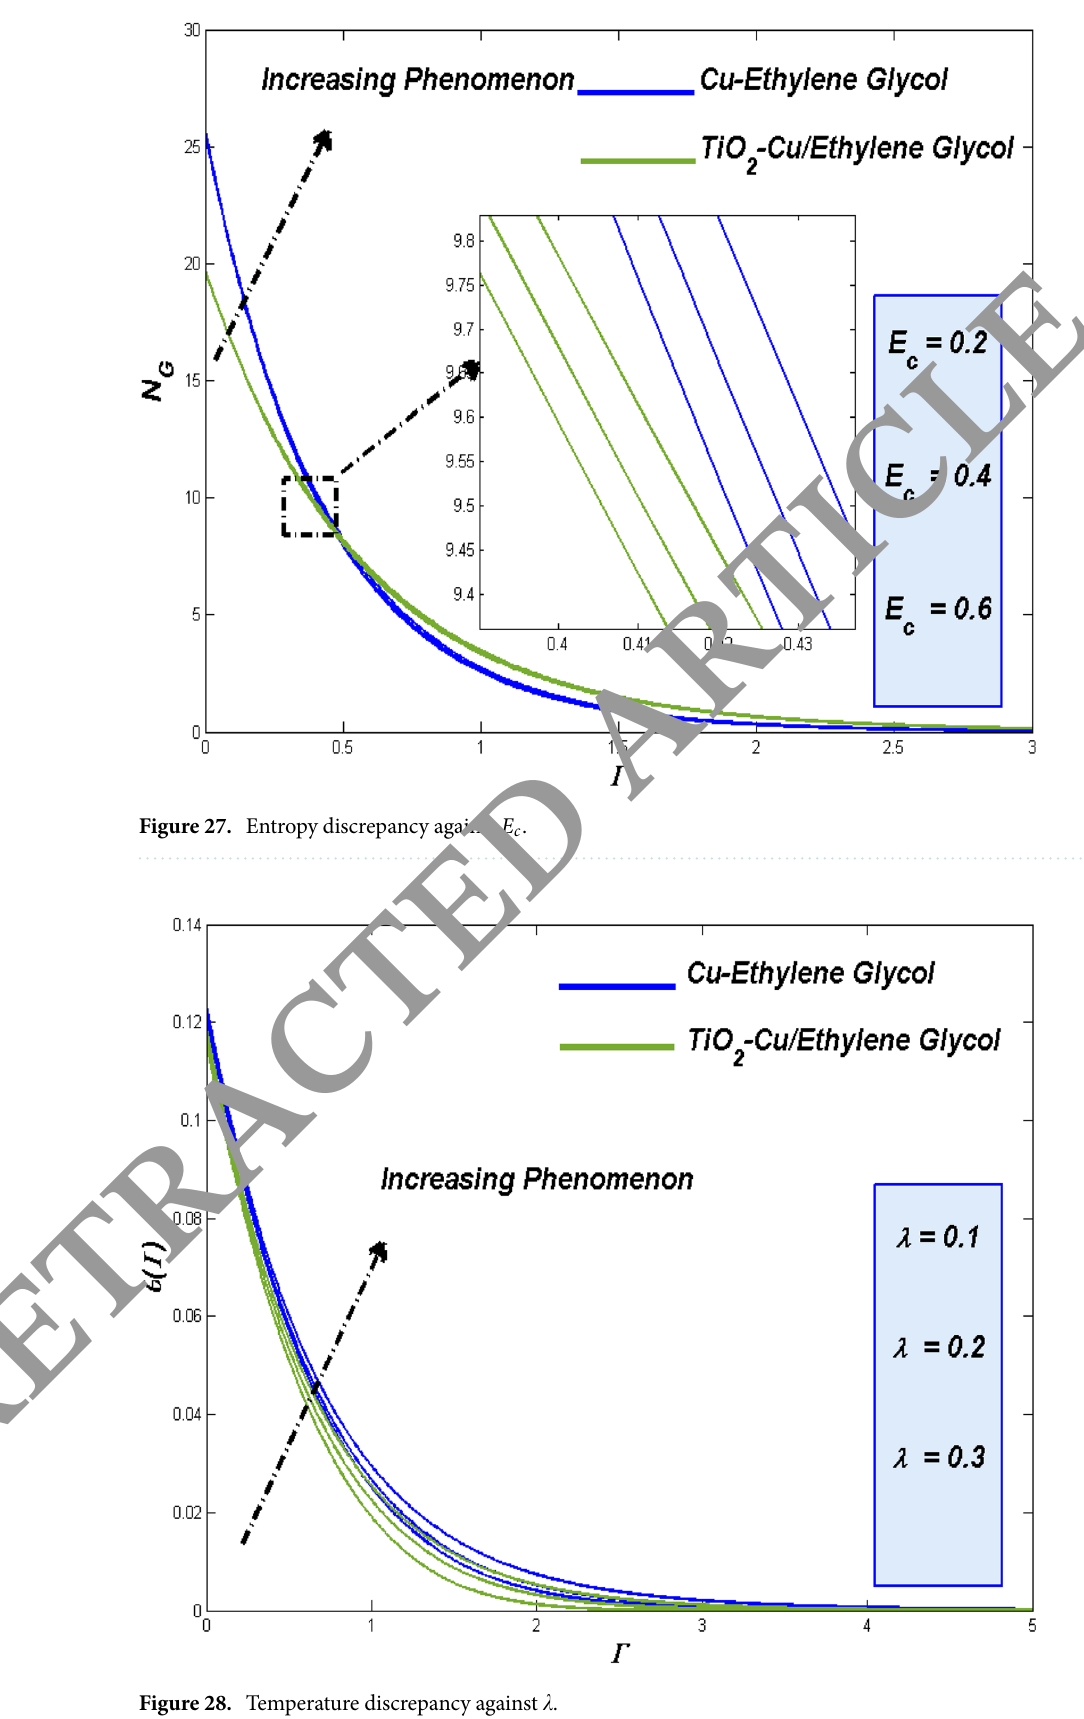
Figure 28. Temperature discrepancy against (cid:31)